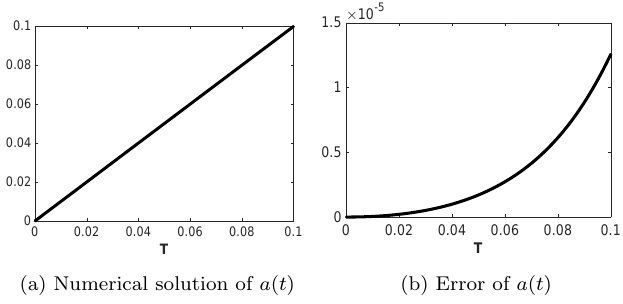
Figure 4. Numerical solution and the error of a ( t ) for t ∈ [0 ,T ] in example 2. α = 1 . 8, T = 0 . 1 and ∆t = 10 − 4 are used. Numerical results show that the absolute maximum error of a ( t ) is 1 . 2587 × 10 − 5 . The numerical solution and the error of w ( x, t ) are given in Figure 5. Unlike the distribution of error in Figure 2(b), the absolute maximum error of w ( x, t ) for this example is not located at the boundary. Numerical results show that the absolute maximum error of w ( x, t ) is 3 . 3290 × 10 − 8